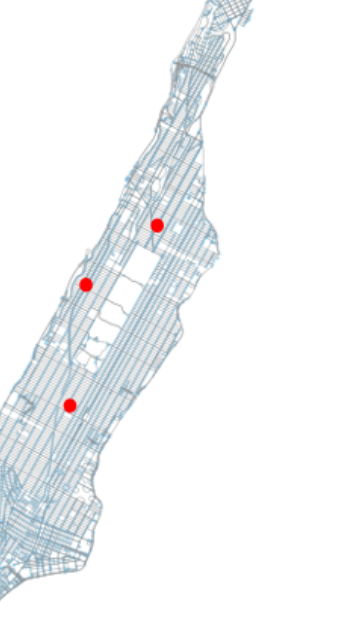
Figure 3. Urban street network of Manhattan, New York City (with area size of 59.1 km 2 ), generated from OpenStreetMap data [68] via OSMnx Python library [69]. The three red dots represent the (approximate) location of chosen drone depots in our